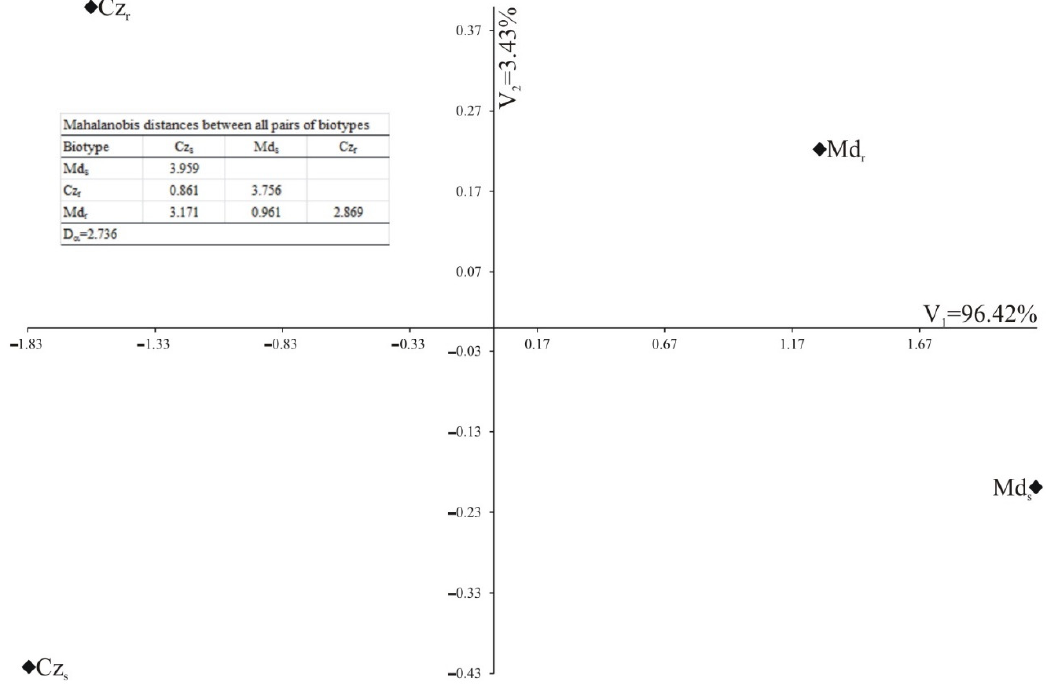
Figure 16. Distribution of combinations of sites and herbicide-resistance (R)/susceptibility (S), based on parameters of winter wheat (WW), in the space of the first two canonical variables (V 1 and V 2 ), in 2019–2020. Sites: Cz—Czes ł awice, and Md—Mydlniki. Subscript “r” denotes the competition of WW with R and the subscript “s” with S.